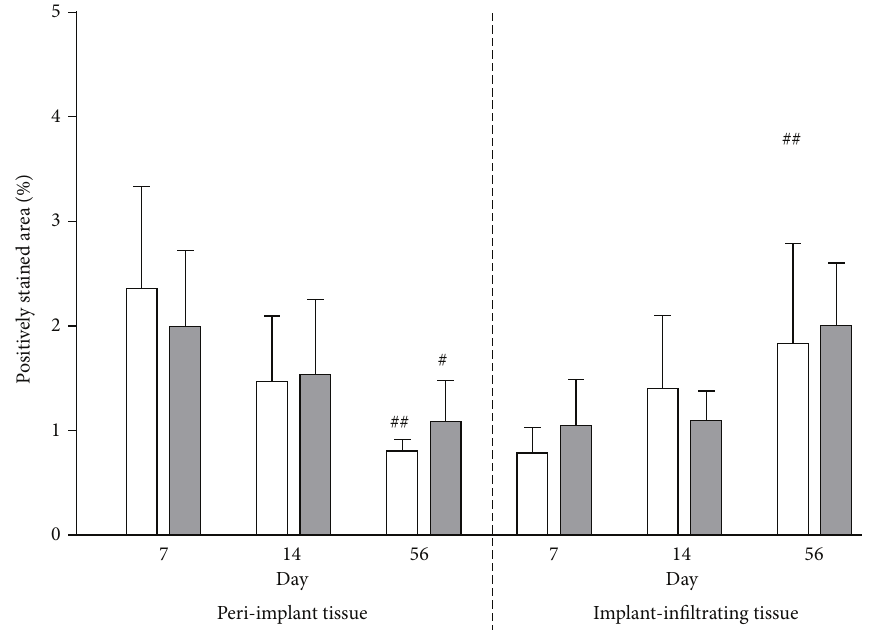
Figure 11: Local inflammatory reaction measured as tissue section area positively stained in immunohistochemistry by CD163-positive tissue macrophages in the peri-implant tissue and implant-infiltrating tissue following i.m. implantation of untreated electrospun PLA meshes (white columns) or PPAAm-coated meshes (gray columns) after 7, 14, and 56 days in Lewis rats. Columns represent the mean, and error bars represent the standard deviation of 8 rats per experimental day. Hash symbols (#) indicate a significant difference ( # 𝑃 < 0.05 ; ## 𝑃 < 0.01 ) versus day 7 (Wilcoxon rank-sum